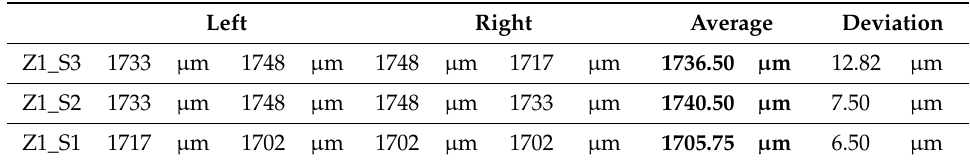
Table 1. Table of measurement results for diameters of the round tension bars, including average and deviation (target diameter: 2 mm).